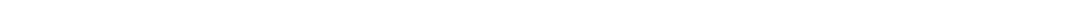
Fig. 7 PDZ-RhoGEF controls junctional F-actin via LIMK and co fi lin. a Immunostaining for PDZ-RhoGEF and RhoA in HT29 cells. Relative intensity of PDZ- RhoGEF and RhoA signals were scanned along the yellow broken line. b Effects of vinculin knockdown on PDZ-RhoGEF (left) or PDZ-RhoGEF knockdown on vinculin (right), as assessed by immunostaining for each molecule. c Effects of PDZ-RhoGEF knockdown on the distribution of F-actin, E-cadherin and MHC-IIA in HT29 cells. Boxed area is enlarged at the right. The ratio of linear to fragmentary junctions was calculated. n = 3272 junctions in 93 colonies for CTRL si; and 1706 junctions in 97 colonies and 1973 junctions in 83 colonies for PDZ-RhoGEF si #1 and #2, respectively, pooled from two independent experiments. d Effects of LIMK1 knockdown or LIMKI/co fi lin (CFL) double knockdown on the distribution of F-actin, E-cadherin and MHC-IIA in HT29 cells. Boxed areas are enlarged at the right. The ratio of linear to fragmentary junctions was calculated. n = 3474 junctions in 90 colonies for CTRL si; 2964 junctions in 97 colonies and 3058 junctions in 88 colonies for LIMK1 si #1 and #2, respectively; and 2381 junctions in 101 colonies and 3224 junctions in 89 colonies for LIMK1 si #1/co fi lin si #1 and LIMK1 si #1/co fi lin si #2, respectively, pooled from two independent experiments. e Effects of PDZ-RhoGEF/ co fi lin double knockdown on the distribution of F-actin, E-cadherin and MHC-IIA in HT29 cells. Boxed area is enlarged at the right. The ratio of linear to fragmentary junctions was calculated. n = 1696 junctions in 95 colonies for PDZ-RhoGEF si #1; and 2009 junctions in109 colonies and 2429 junctions in 105 colonies for PDZ-RhoGEF si #1/co fi lin si #1 and PDZ-RhoGEF si #1/co fi lin si #2, respectively, pooled from two independent experiments. f Effects of vinculin/co fi lin double knockdown on the distribution of α E-catenin in HT29 cells. Images in c , d , and e were obtained with Airyscan. Scale bars, 10 μ m ( a , b , c left, d left, e left, and f ) and 5 μ m ( c right, d right, and e right). See also Supplementary Fig.